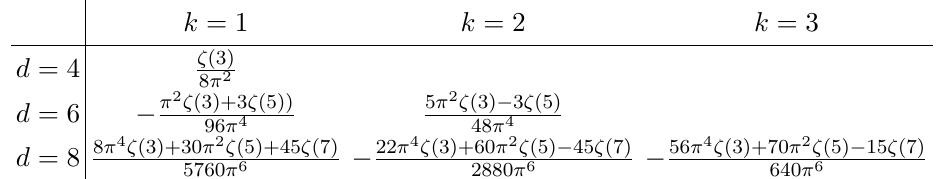
Table 7 . The constant term in ∆ F ( ND )